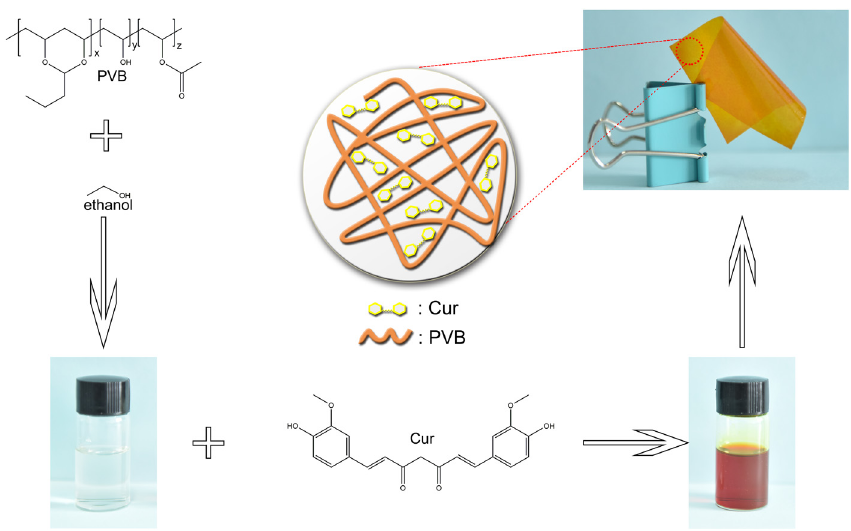
Figure 1: Schematic diagram of Cur - loaded PVB fi